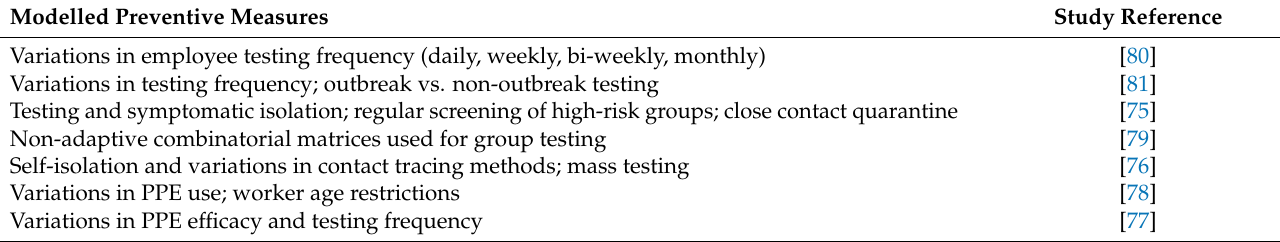
Table 6. Map of modelled workplace COVID-19